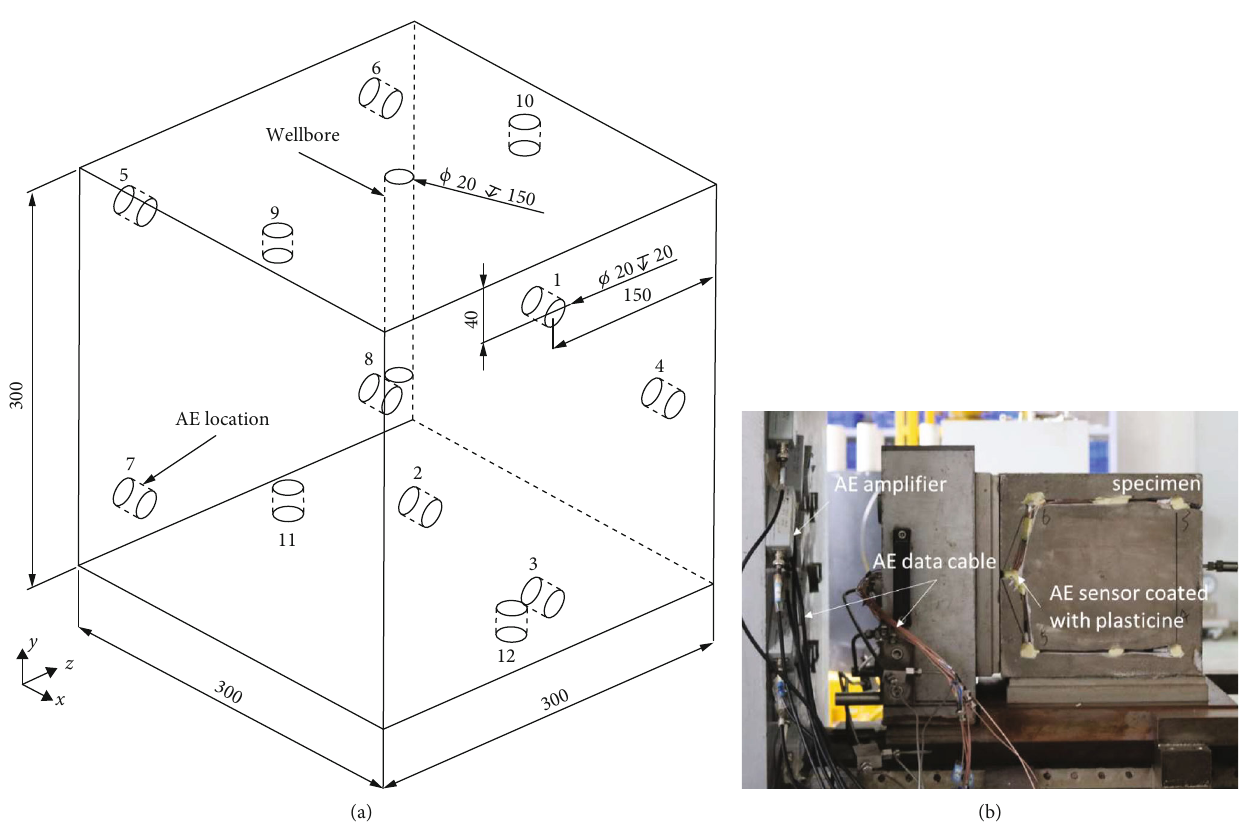
Figure 2: Schematic of the AE hydraulic fracturing system.